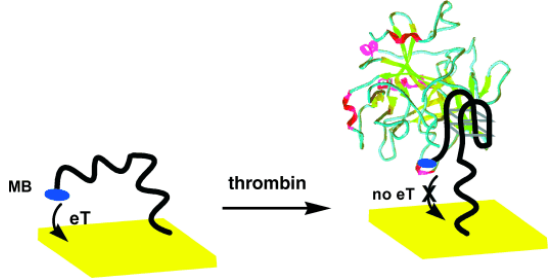
Verlag GmbH & Co. KGaA. Reprinted with